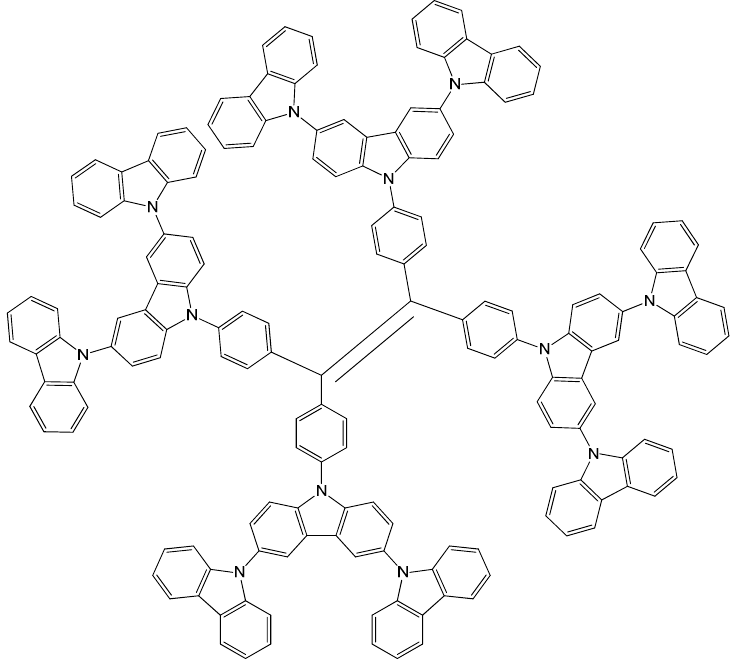
Figure7. Chemicalstructureofdendrimer1,1,2,2-tetrakis(4-(9’H-[9,3’:6’,9”- tert -carbazol]-9’-yl)phenyl)ethene Figure 7. Chemical structure of dendrimer 1,1,2,2-tetrakis(4-(9’H-[9,3’:6’,9’’- tert -carbazol]-9’- yl)phenyl)ethene (TPETCz).